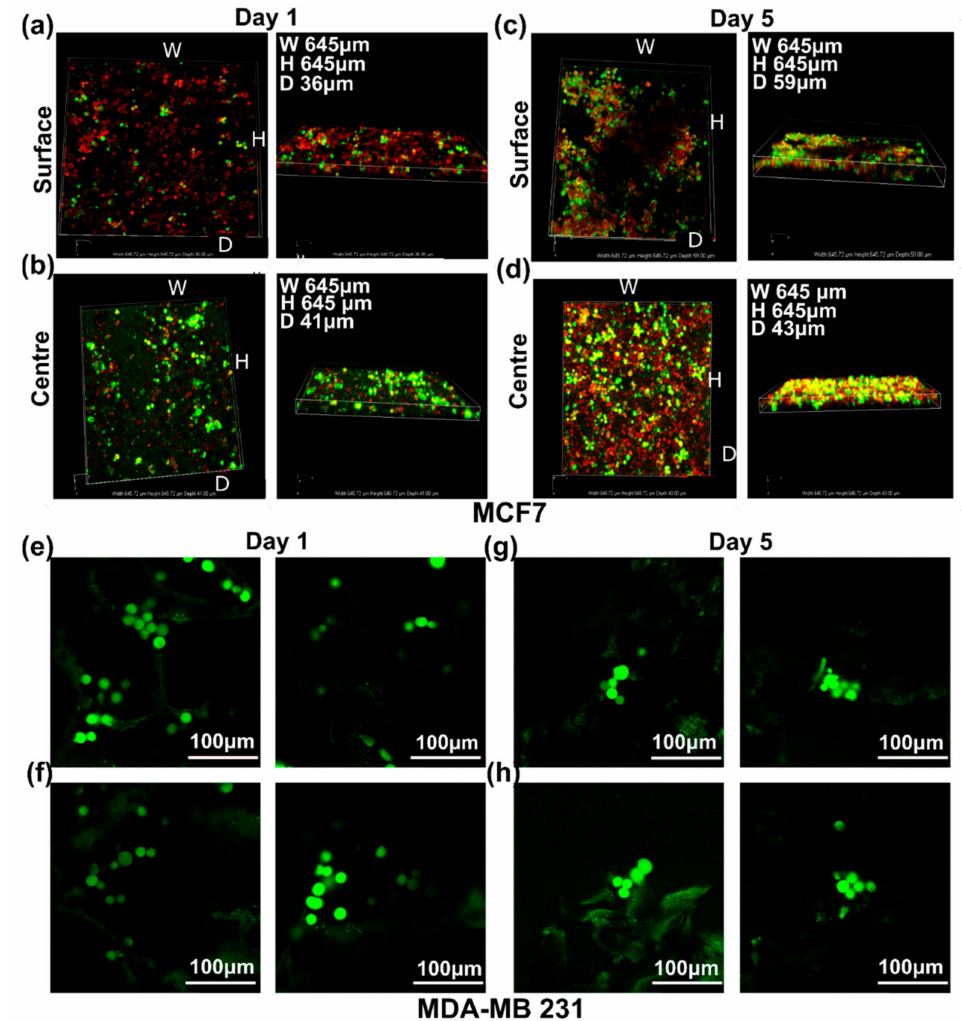
Figure 5. The 3D images of cells grown on 10 mm × 10 mm × 8 mm PHA-based 3D scaffolds ( a – d ). MCF7 cells cultured on 3D PHA scaffolds at ( a , b ) Day 1 and ( c , d ) Day 5 stained with TMRM (Red) and Calcein Green (Green), both for live cells. ( b ) MDA-MB-231 cells cultured on 3D PHA scaffolds at ( e , f ) Day 1 and ( g , h ) Day 5 stained with Calcein Green (Green) live cells and Ethidium bromide (Red) dead